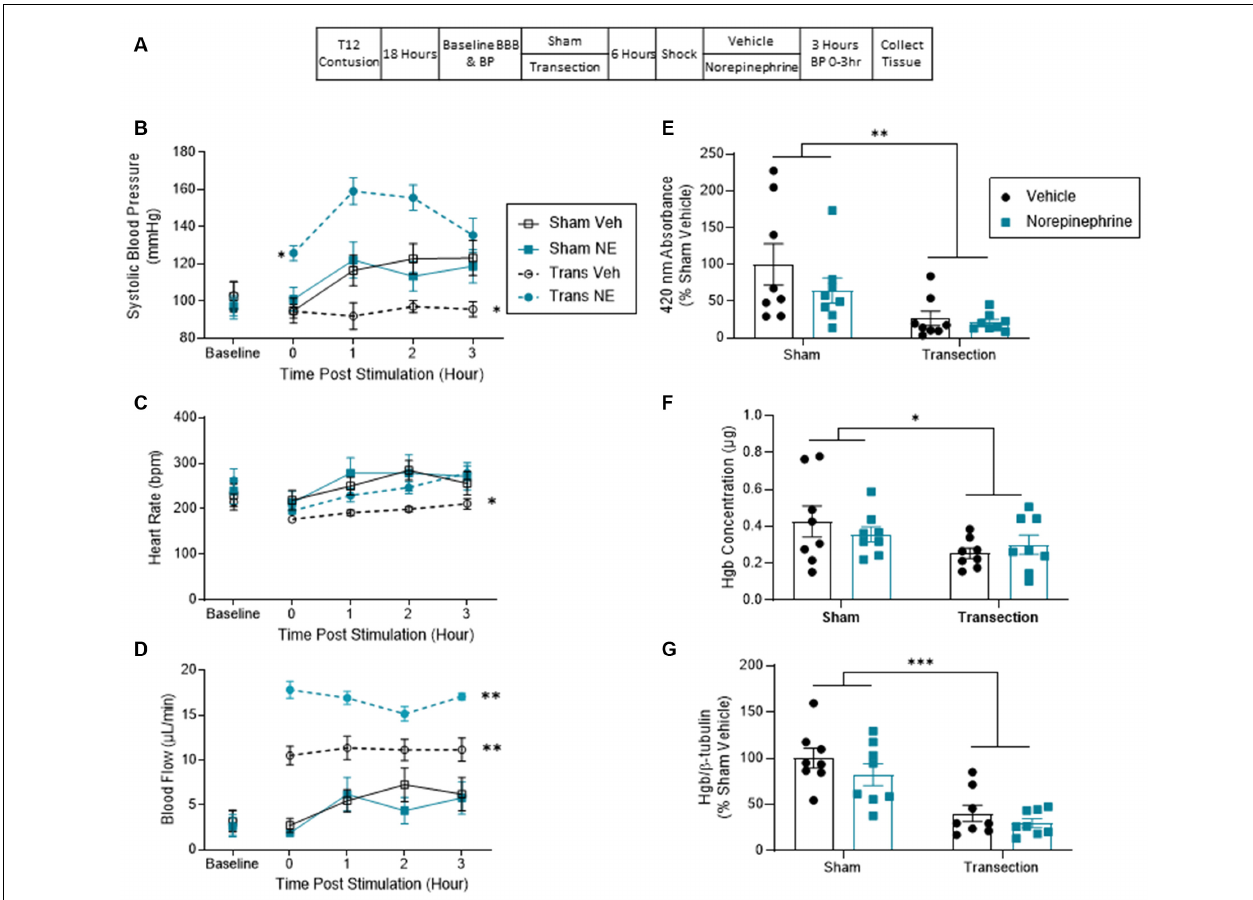
FIGURE 3 | Norepinephrine increased blood pressure in transected but not sham-operated rats. This significant rise did not induce hemorrhage at the injury site. (A) Experimental design and timeline for experiment 3. (B) Sham-operated shocked rats exhibited a rise in systolic blood pressure relative to vehicle-treated shocked animals that were transected. Transected rats that were given NE exhibited the greatest increase in BP. (C) Sham-operated rats exhibited greater heart rate throughout testing. Transected rats that received vehicle exhibited the lowest heart rate throughout the 3 h. (D) Spinally transected animals exhibited higher levels of tail blood flow, relative to sham-operated rats. NE increased tail blood flow in transected, but not sham-operated, rats. (E) Spectrophotometry results at 420 nm for hemoglobin revealed that sham-operated shocked rats exhibited greater absorbance, relative to the transected animals. NE had no effect. (F) Drabkin’s assay and western blot (G) showed a similar pattern. Only sham-operated rats showed an increase in hemoglobin content and expression at the injury site. Asterisks indicate statistical significance ( ∗ p < 0.05, ∗∗ p < 0.01, ∗∗∗ p < 0.001, n = 8). An asterisk placed over a group indicates that the group differs from all the others. Error bars represent the standard error of the mean